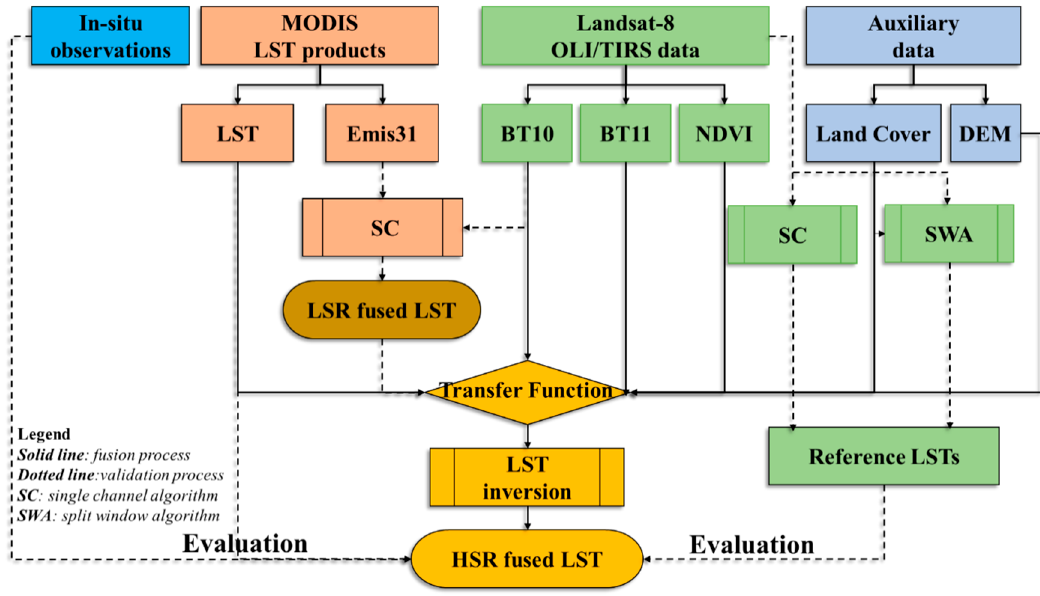
Figure 4. Flowchart of the pixel-based multi-spatial resolution adaptive fusion modeling framework (pMSRAFM) implemented for the LST fusion of Landsat-8 and MODIS data.